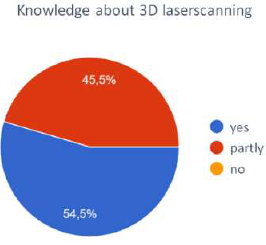
Figure 5: Knowledge about 3D scanning technology and 3D data processing.